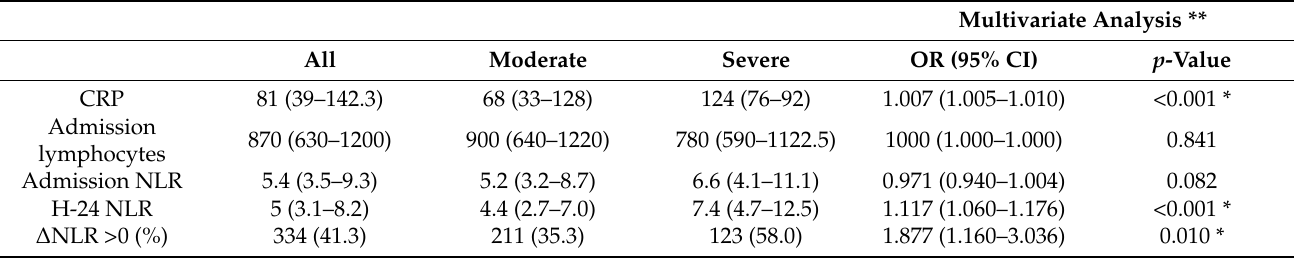
Table 2. Biochemical factors associated with severe COVID-19 (admission to the